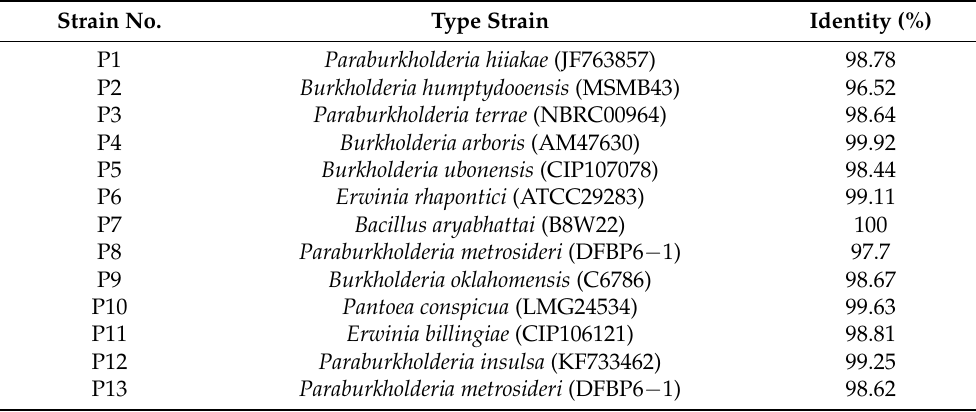
Table 8. Identification based on 16SrDNA